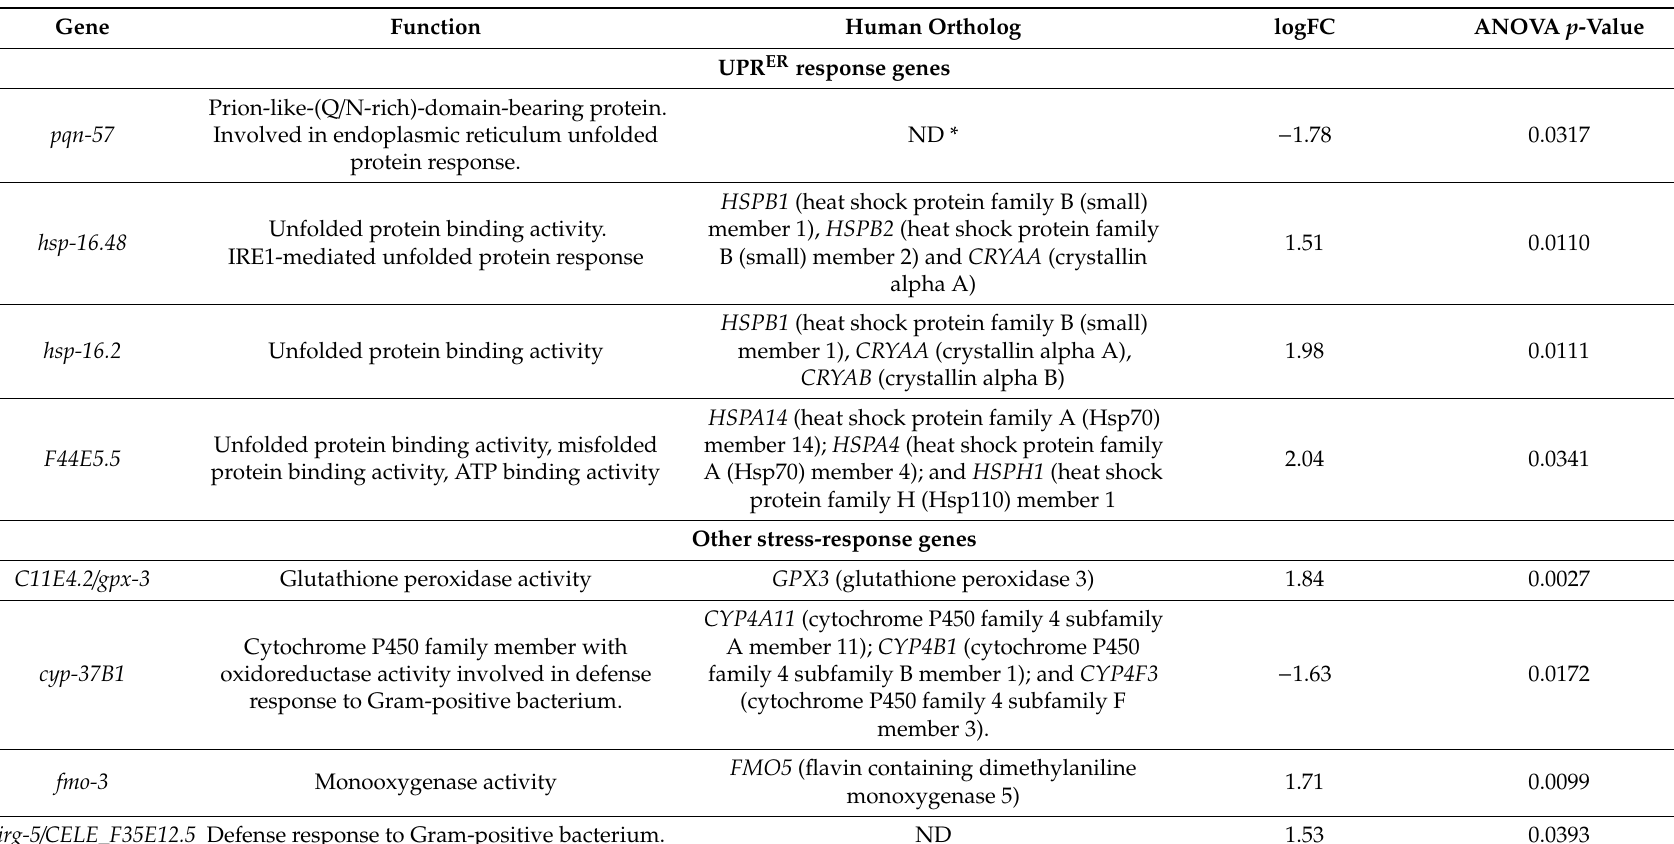
Table 6. Top upregulated and downregulated genes based on fold change (with ANOVA p < 0.05) following vanillic acid treatment (100 µ